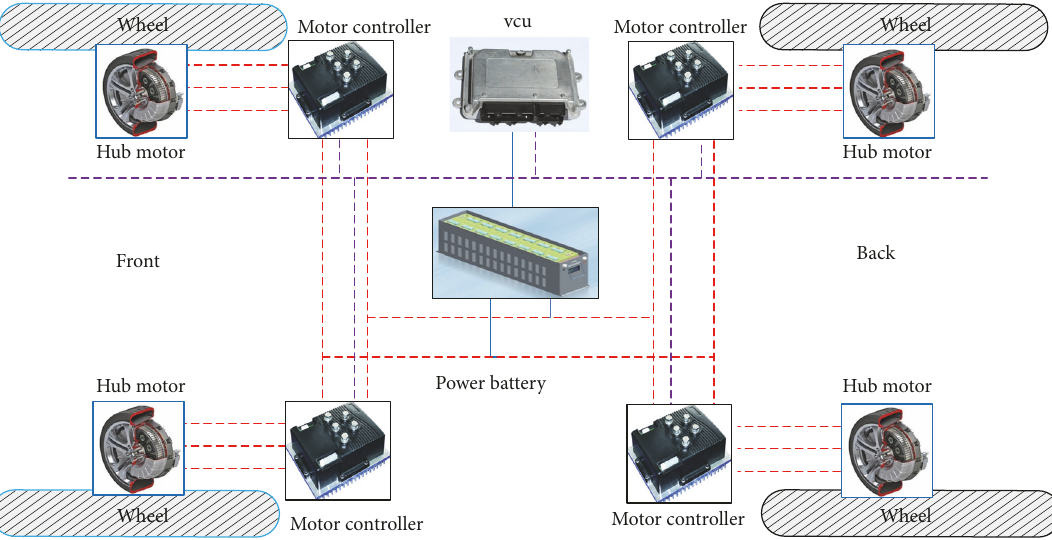
Figure 3: Four-wheel drive mode.